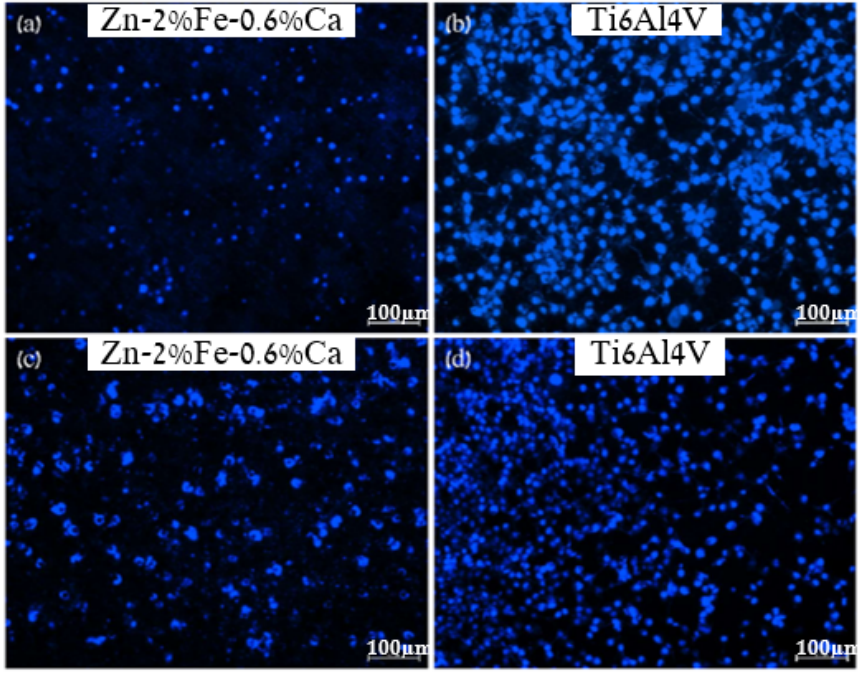
Figure 10. Typical fluorescence micrographs of NucBlue stained 4T1 cells attached to the surface of Zn-2%Fe-0.6%Ca and Ti6Al4V alloy, respectively ( a , b ) after 24 h of incubation; ( c , d ) after 48 h of incubation.